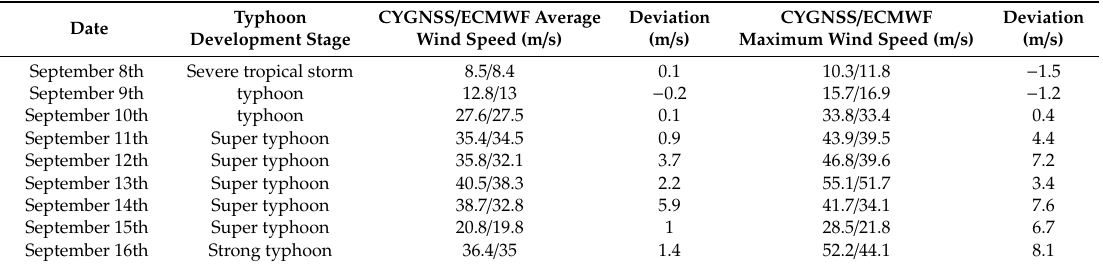
Table 1. Comparison of average and maximum wind speeds from CYGNSS and